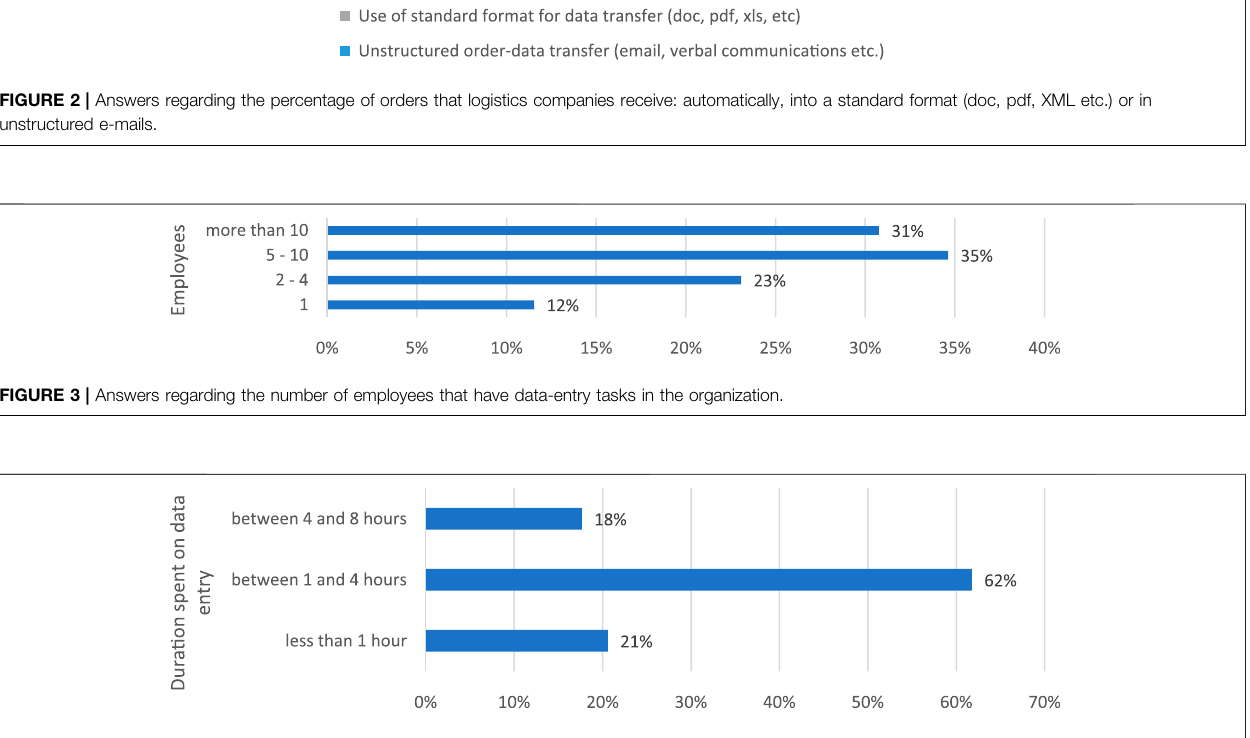
Frontiers in Future Transportation |